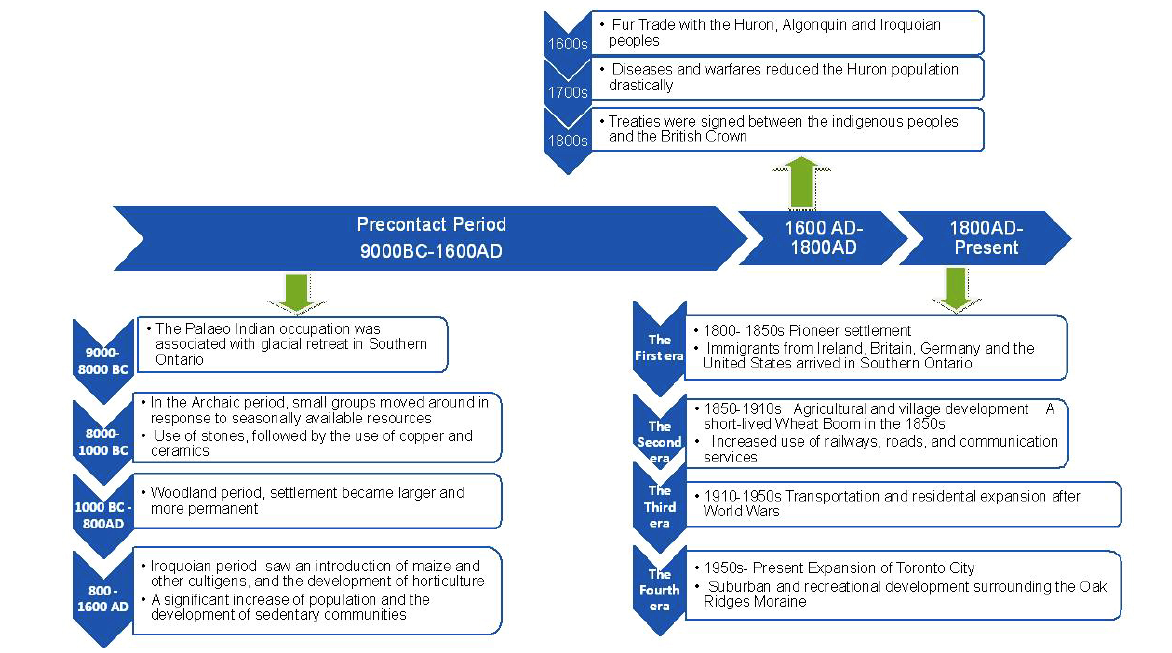
Fig. 5. Historical timeline of the Oak Ridges Moraine areas (Sources: Fisher and Alexander 1993, Historica et al. 1994, McCarthy